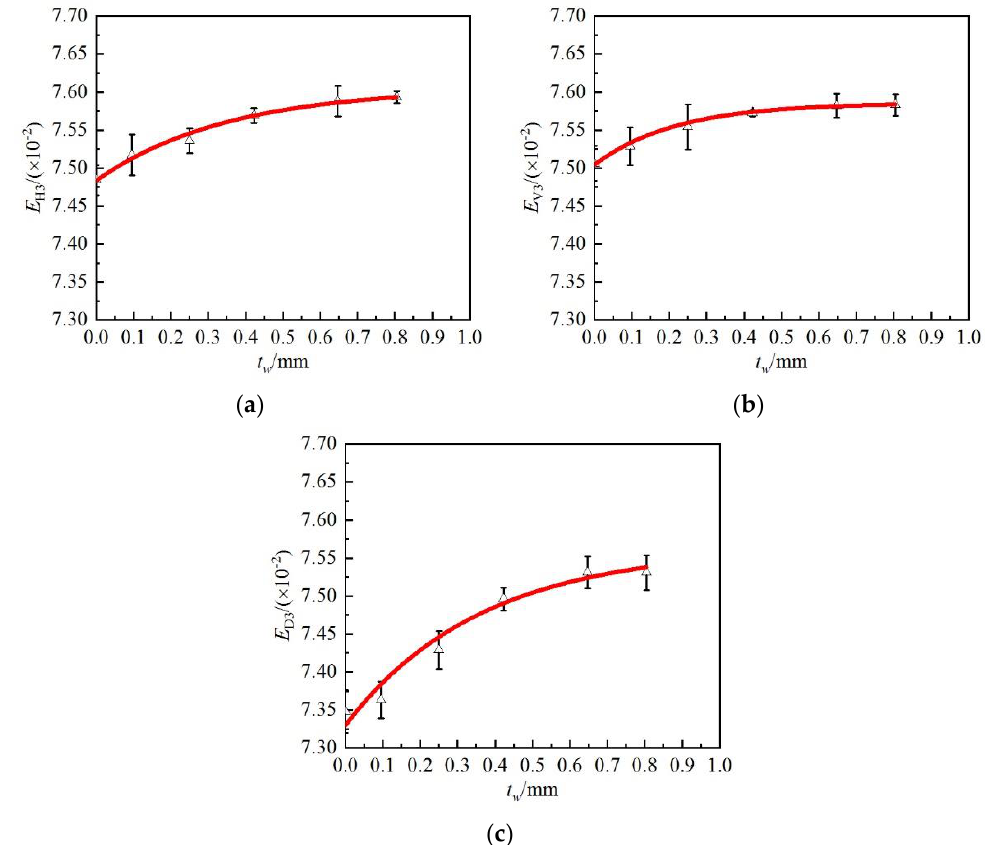
Figure 3. Relationship between energy values of the sub-images obtained after applying the three-level wavelet transform and corrosion depths: ( a ) E H3 - t w , ( b ) E V3 - t w , ( c ) E D3 - t w .